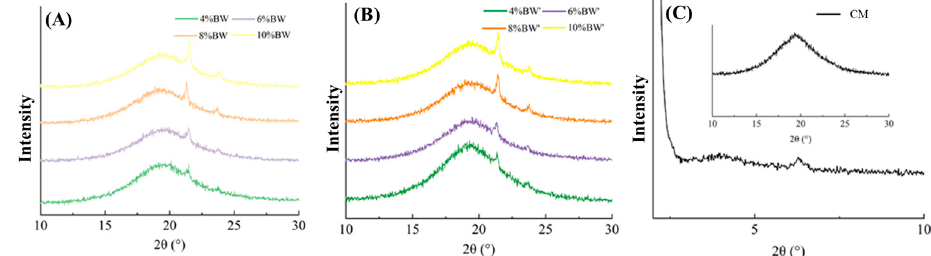
Figure 4. XRD patterns of BW oleogel-based margarine ( A , B ) and commercial margarine (C), re- spectively.